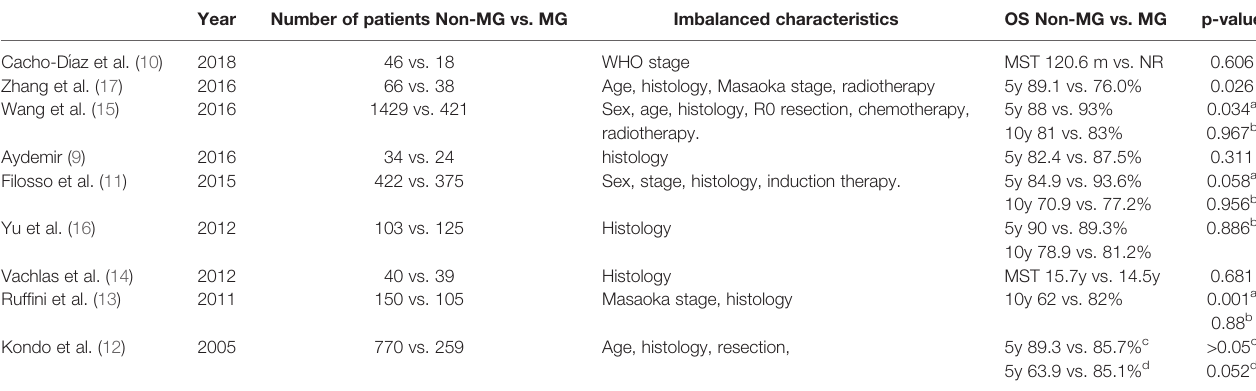
TABLE 3 | Survival Measures in Previous